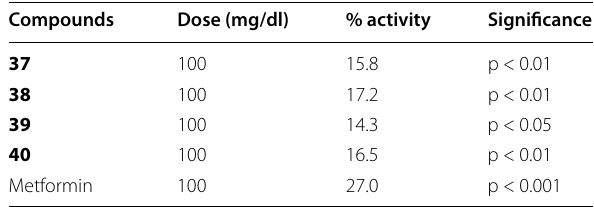
Table 12 Antidiabetic activity of synthesized compounds Compounds Dose (mg/dl) %